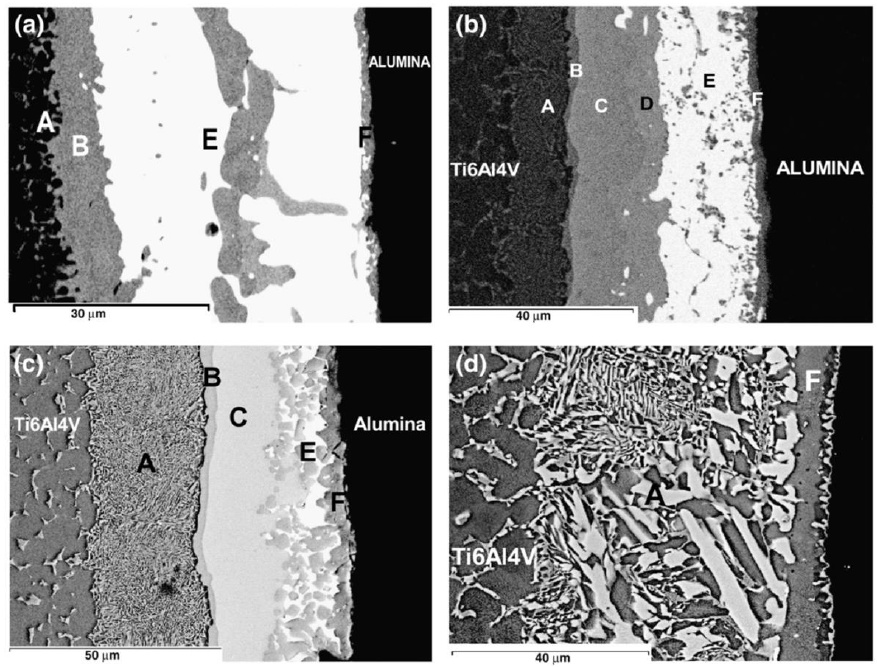
Figure 21. SEM images of Ti6Al4V/Al 2 O 3 interface microstructure at bonding temperature of 750 °C for: ( a ) 10 min; ( b ) 20 min; ( c ) 30 min; ( d ) 60 min, reproduced from Reference [48] with permission of Elsevier, 2009.